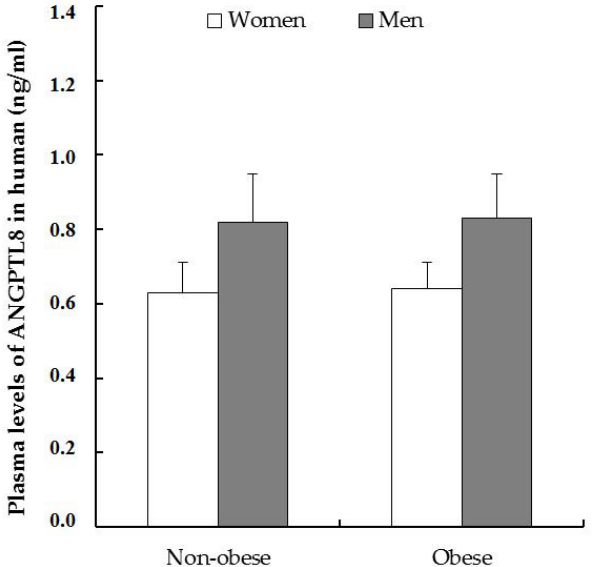
Figure 1. Plasma circulating levels of C-terminal 139–198 form of ANGPTL8. Data was expressed as mean ± the standard error of the mean (SEM), and the values in the non-obese women were 0.63 ± 0.10 ng / mL, n = 11 and obese women 0.64 ± 0.04 ng / mL, n = 33. In non-obese men 0.82 ± 0.09, n = 10 versus 0.83 ± 0.10 ng / mL in obese men, n = 14. The Student’s t -test analysis in non-obese patients (women vs. men) was p = 0.0763, and in obese patients (women vs. men) p = 0.176